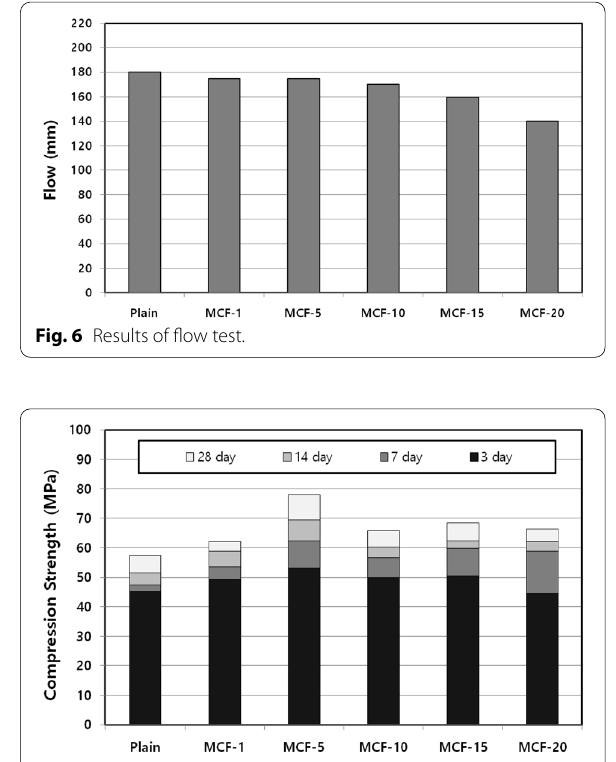
Fig. 7 Result of compressive strength